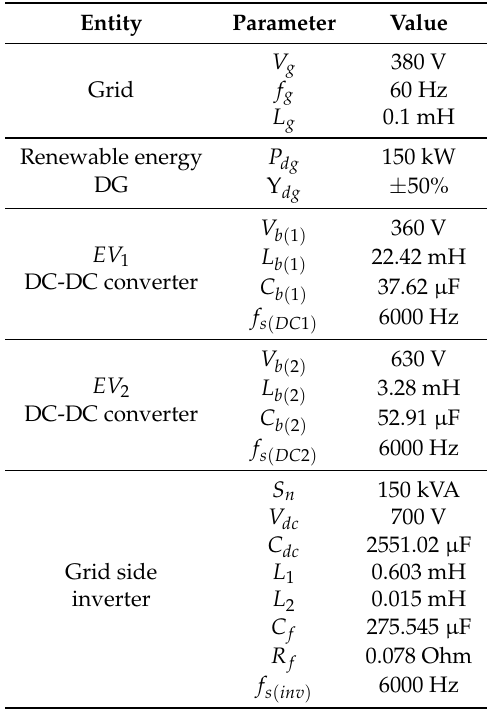
Table 3. Parameter